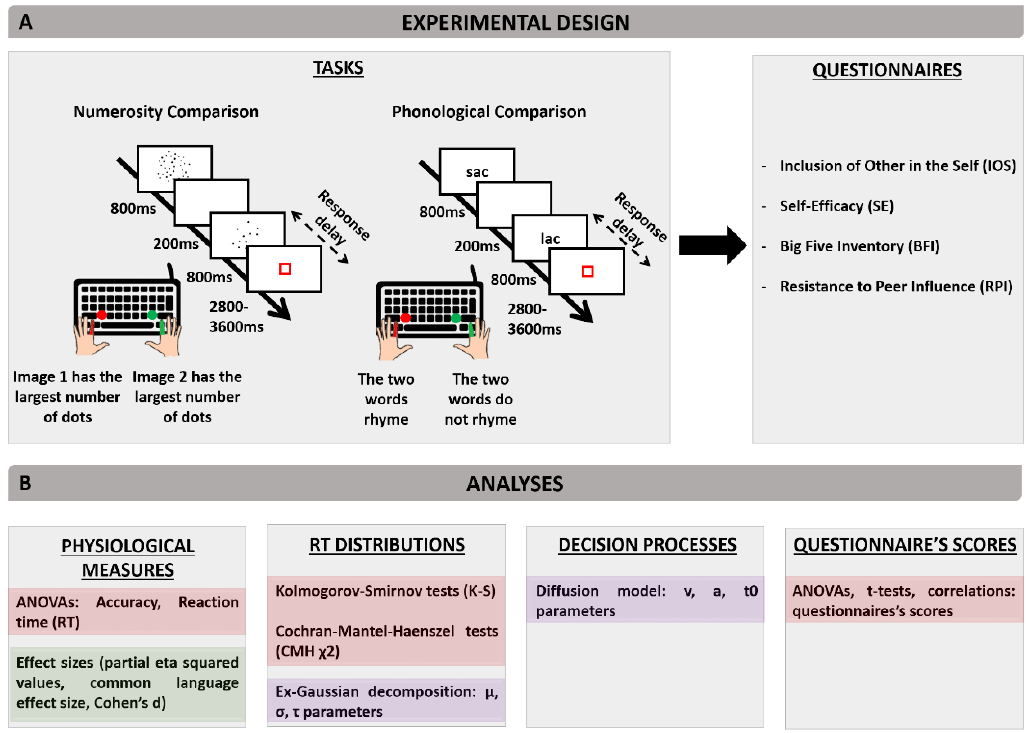
Figure 1. Schematic illustration of experimental design ( A ) and overview of conducted analyses ( B ). The task mixed two trial types (numerosity and phonological comparisons), and was followed by com-pletion of 4 questionnaires. Statistics are given in red boxes, effect sizes in green boxes, and computa-tional analyses in purple boxes.